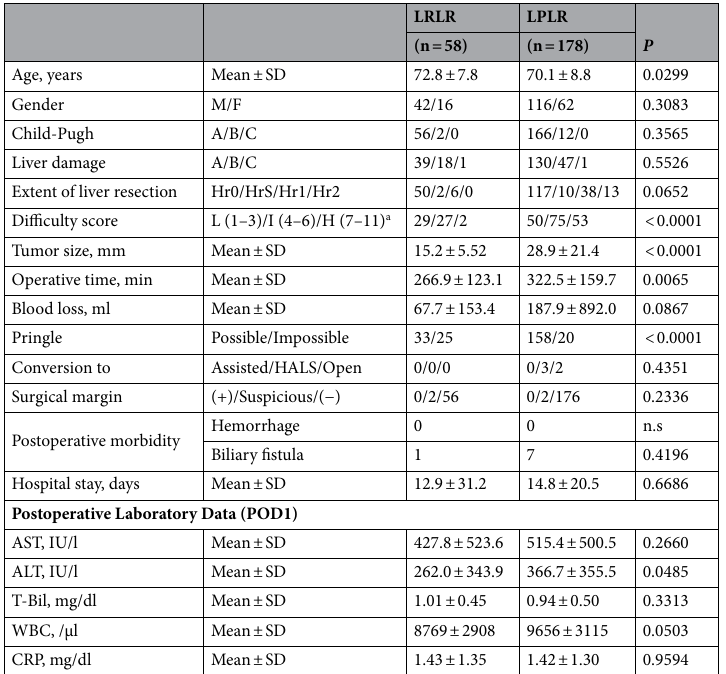
Table5. Patient characteristics and surgical results of laparoscopic liver resection in HCC patients. HCC hepatocellular carcinoma, CCC cholangiocellular carcinoma, Mets metastasis, HALS hand-assisted laparoscopic surgery, n.s. not significant. a L: low, I: intermediate, H: